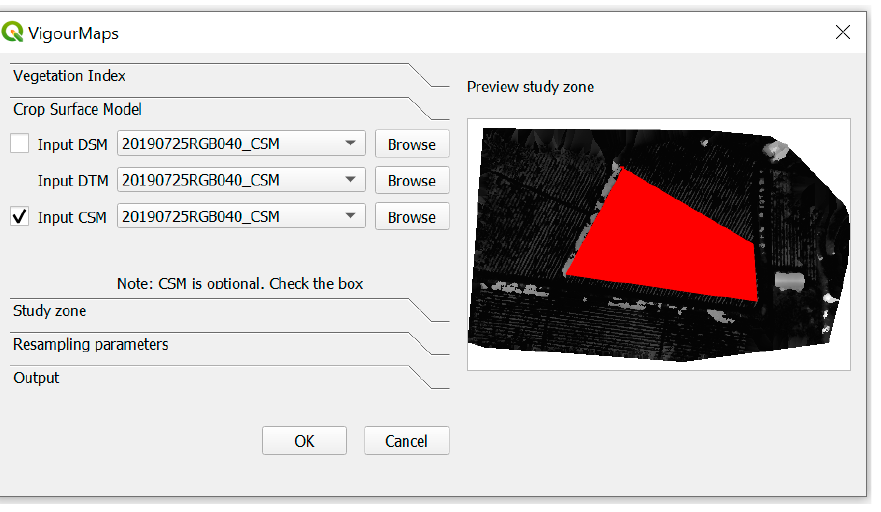
Figure 3. Study zone defined in the Preview study zone window using a red polygon (manually defined).